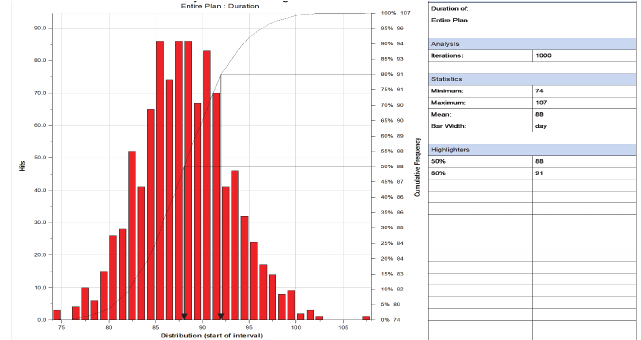
Fig. 4. Original Plan Finish Duration Histogram